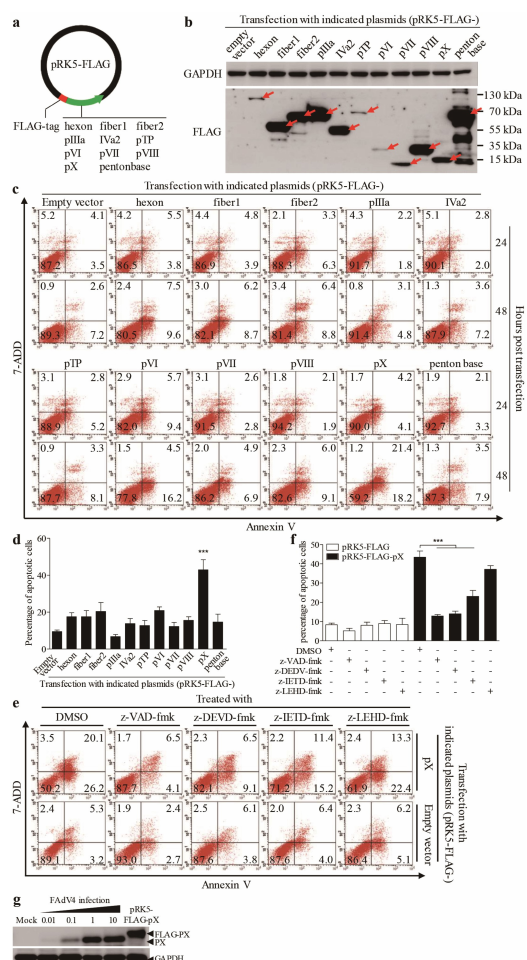
Figure 2. Ectopic expression of PX protein in LMH cells induced apoptosis. ( a ) Schematic diagram of recombinant eukaryotic expression vector pRK5-FLAG-viral genes. We constructed a total of 11 structural proteins into the eukaryotic expression vector pRK5-FLAG. ( b ) Ectopic expressions of FLAG-viral protein recombinants in LMH cells. Recombinant plasmids (pRK5-FLAG-hexon, -fiber1, -fiber2, -pIIIa, -IVa2, -pTP, -pVI, -pVII, -pVIII, -pX and -penton base) were individually transfected into LMH cells using the jetPRIME TM transfection reagent. Forty-eight hours after transfection, cells were harvested and examined with Western Blot using anti-FLAG antibodies. ( c , d ) Twenty-four or 48 h after transfection as above described, cells were harvested, stained with Annexin V-PE and 7-AAD, and analyzed by flow cytometry. Empty plasmid-transfected cells were used as controls ( c ). The percentage of apoptotic cells 48 h post-transfection (as in c ) was quantified ( d ). ( e ) Inhibition of PX-induced apoptosis by caspase inhibitors. LMH cells were seeded on 12-well plates and cultured overnight. Caspase inhibitors (z-VAD-fmk, z-DEVD-fmk, z-IETD-fmk and z-LEHD-fmk) were added to cell culture for 2 h prior to transfection with pRK5-FLAG-pX. Six hours after transfection, cells were again cultured with a caspase inhibitor. Forty-eight hours after transfection, LMH cells were harvested, stained with Annexin V-PE and 7-AAD, and analyzed by flow cytometry. The percentage of